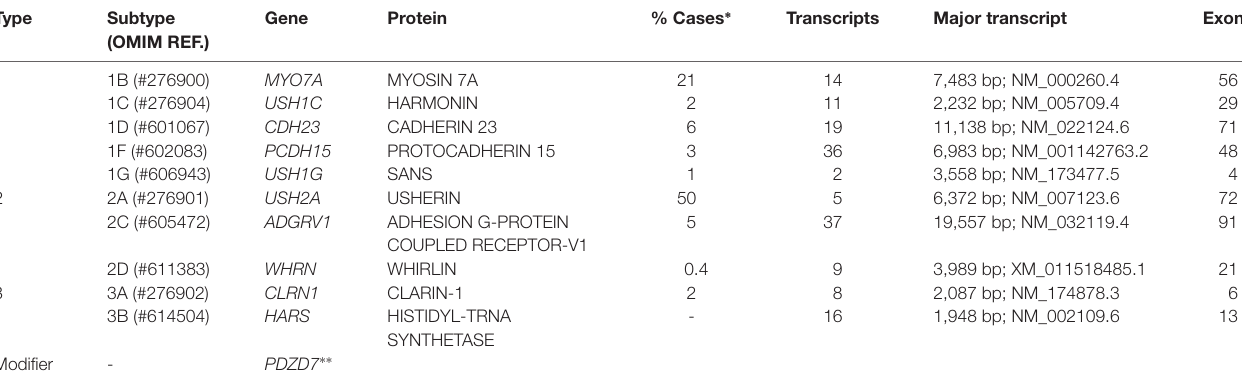
TABLE 1 | Genes and proteins associated with various Usher syndrome subtypes.